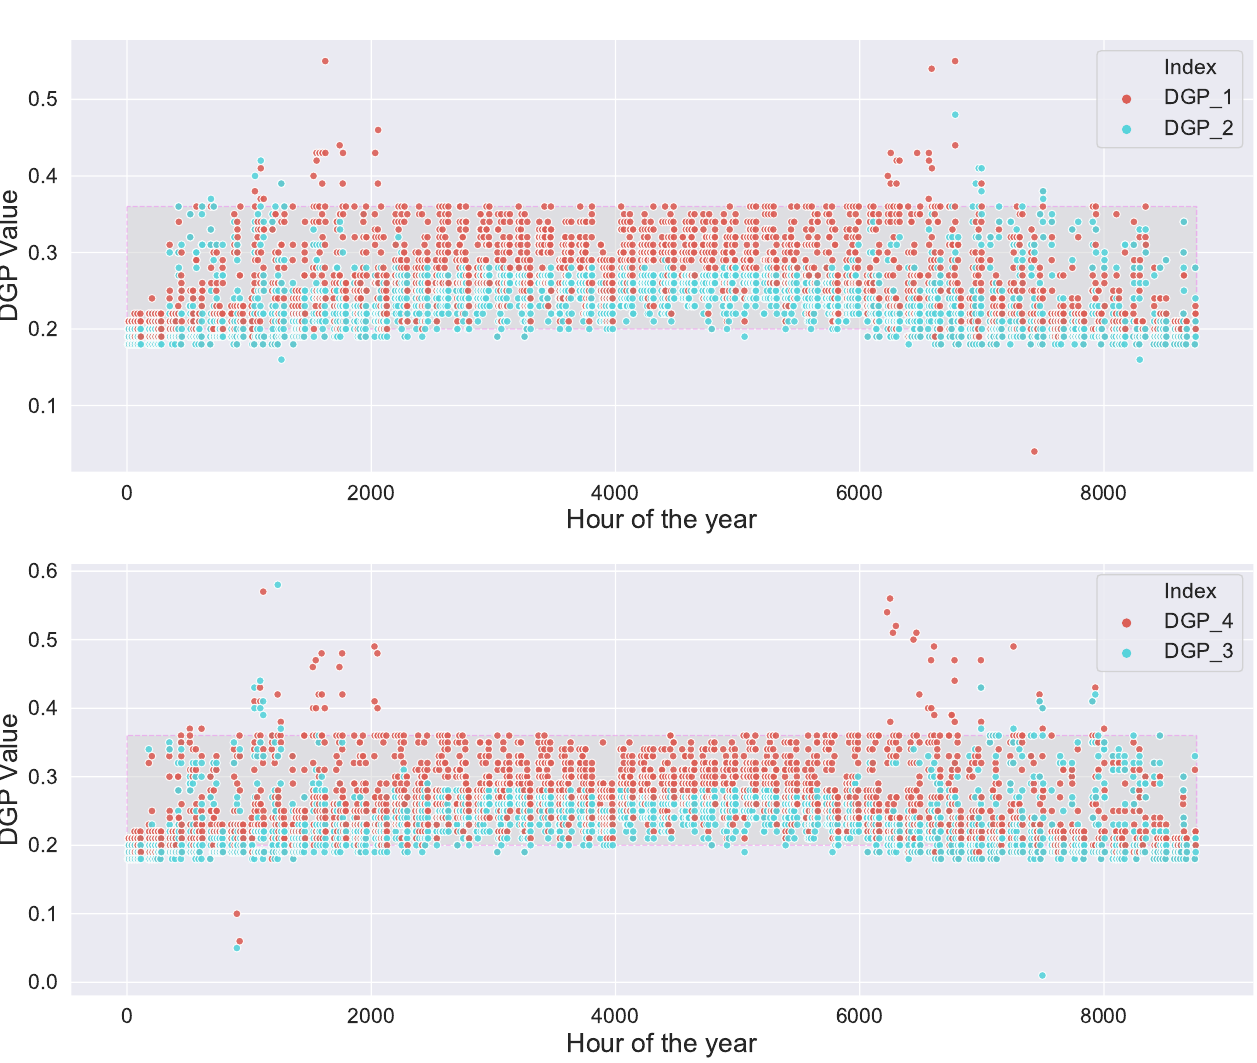
Figure 17. Glare occurrence for all the during the course of the year with the DQN agent’s